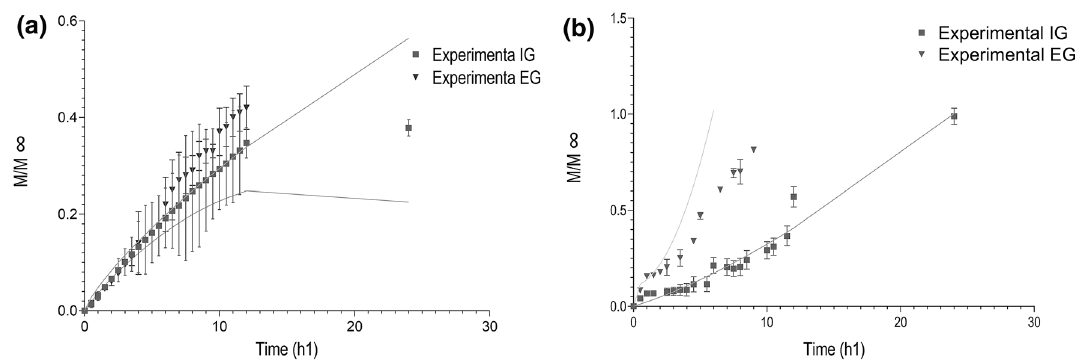
Figure 6. Kinetics release profile for ( a ) polyphenol compounds, and bixin ( b ) present in annatto extract encapsulated by EG (filled circles) and by IG (filled triangles) in a 0.1 M sodium phosphate buffer medium at a pH of 6.5, 25 °C and 210